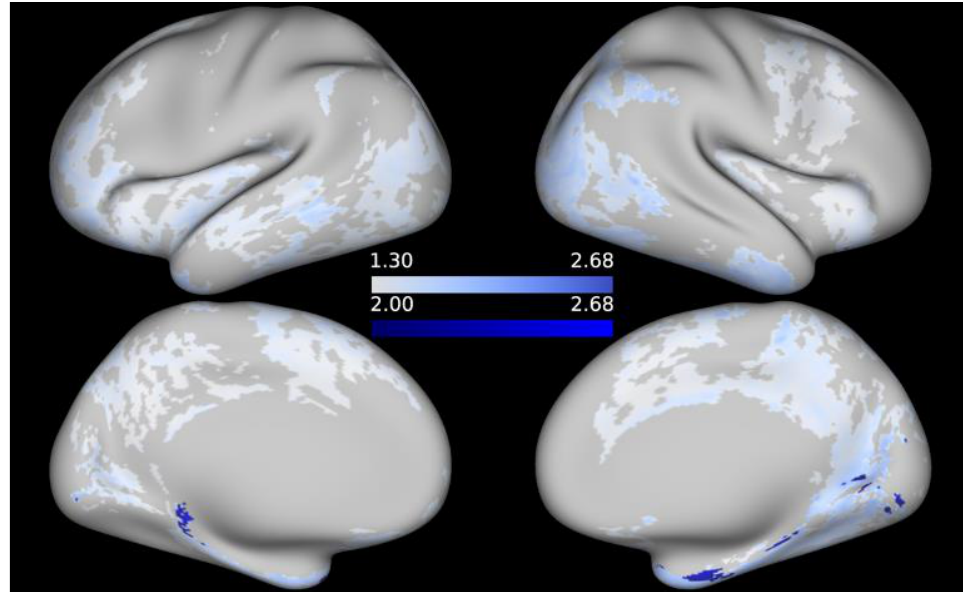
Figure 2. t -statistical map representing areas in which working memory was negatively associated with T1w/T2w contrast. Thresholded at − log10( p ) ≥ 1.3 (pale blue regions), respectively − log10( p ) ≥ 2 (opaque); p -values are uncorrected.